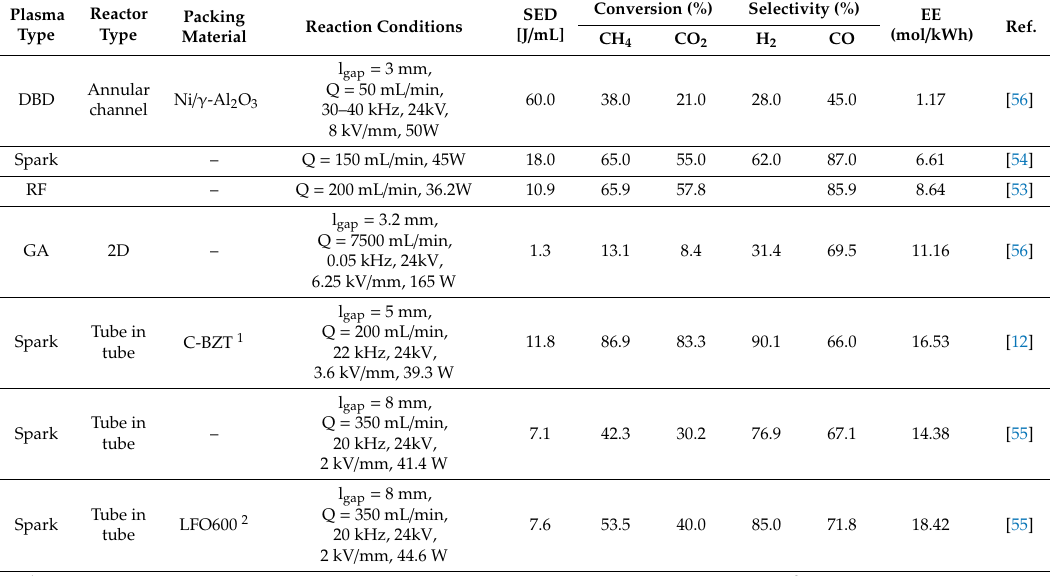
Table 3. Comparison of dry reforming of methane assisted by di ff erent